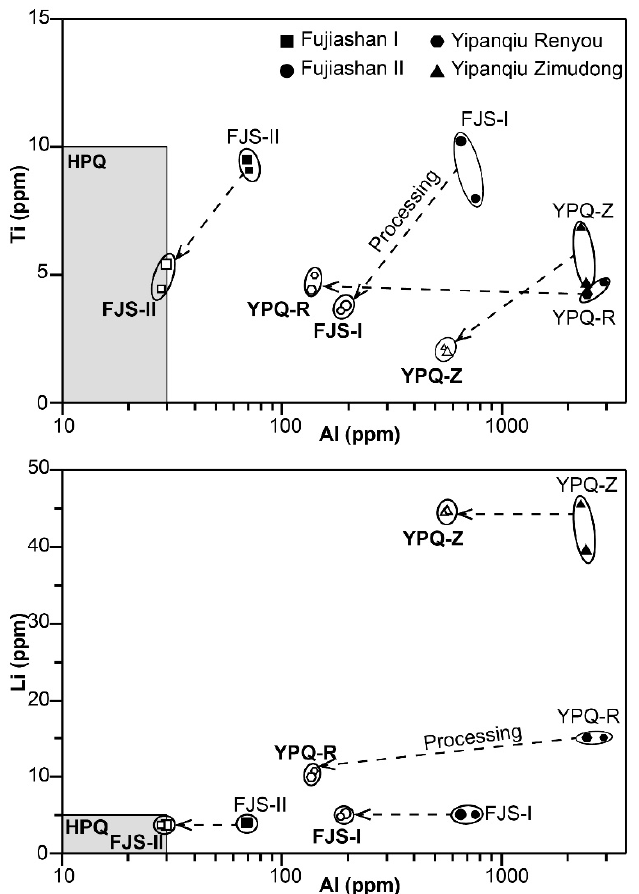
Figure 6. Diagrams of Al versus Li and Ti concentrations determined from inductively coupled plasma optical emission spectroscopy (ICP-OES) analyses of the investigated quartz. Shaded area shows the high purity quartz field according to Harben [15] and Müller et al. [6]. Note the HPQ upper concentration limits are constrained on the basis of lattice-bound elements in quartz. Larger symbols indicate coarse fraction (40–80 mesh) and those of smaller are finer quartz fraction (80–120 mesh). Solid and empty symbols represent analyzed data of raw and processed quartz, separately.